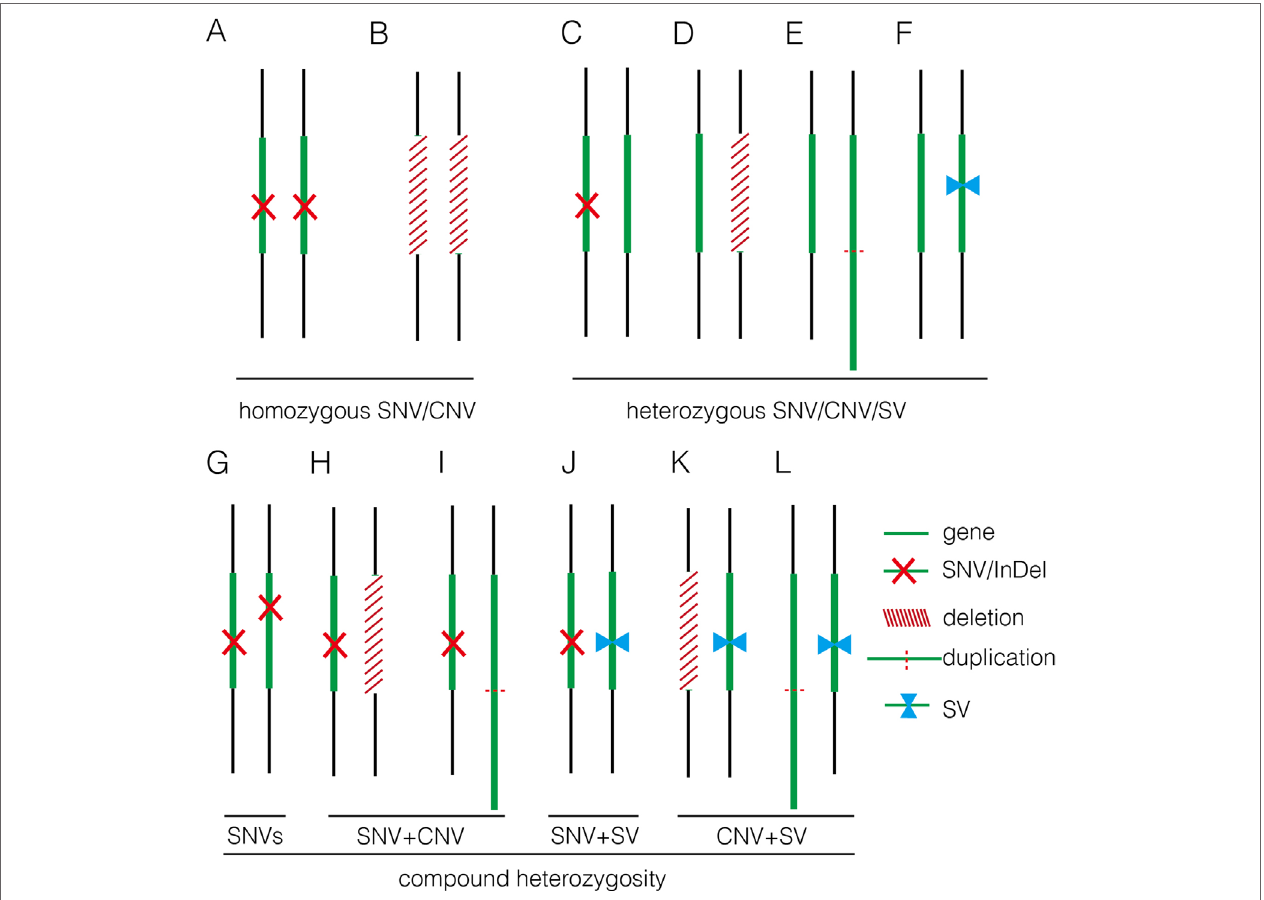
FIGURE 5 | Summary of various genomic variants proposed to contribute to human diseases. (A) and (B) show that the disease was caused by a homozygous SNV or a homozygous deletion commonly affecting a disease-causing gene in autosomal recessive manner. (C – F) indicate that the disease was caused by a heterozygous SNV [NM_004333: c.G1411T (p.V471F) in 16C1953], a heterozygous deletion (seq[hg19] del(16)(p11.2)dn chr16:g.29538256_30290160del in 18NT0018), a triplication (seq[hg19] trp(2)(q11.2q21.1)dn chr2:g.98070117_131452568trp in 17C0070), and a heterozygous SV (seq[hg19]ins(2;12) (q33.2;q24.31)g.[chr2:203384219_203384293inschr12:122757221_122907271cx] chr12:g.122757221_122907271del in 18NT0003), respectively, commonly affecting a disease-causing gene in autosomal dominant manner; (G – L) show that the disease was contributed by compound heterozygosity, a combination of two or more variants. (G) The typical mode of compound heterozygosity (NM_018076:c.1614_1615del (p.P538fs) and NM_018076: c.C2306A (p.P769H) from different parental origin in 14C1232). A gene content is indicated by a green bar. SNV/InDel, deletion, duplication, and SV are indicated by a red cross, a white bar (with red slashes), an elongated green bar (with red dotted line), and a pair of opposite blue arrows,